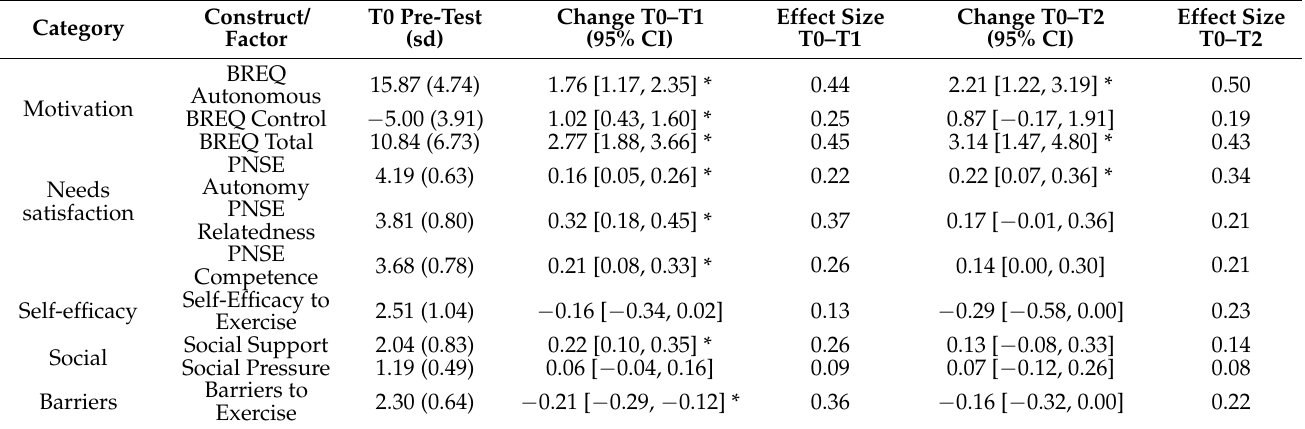
Table 3. Results of the self-reported measurements regarding physical